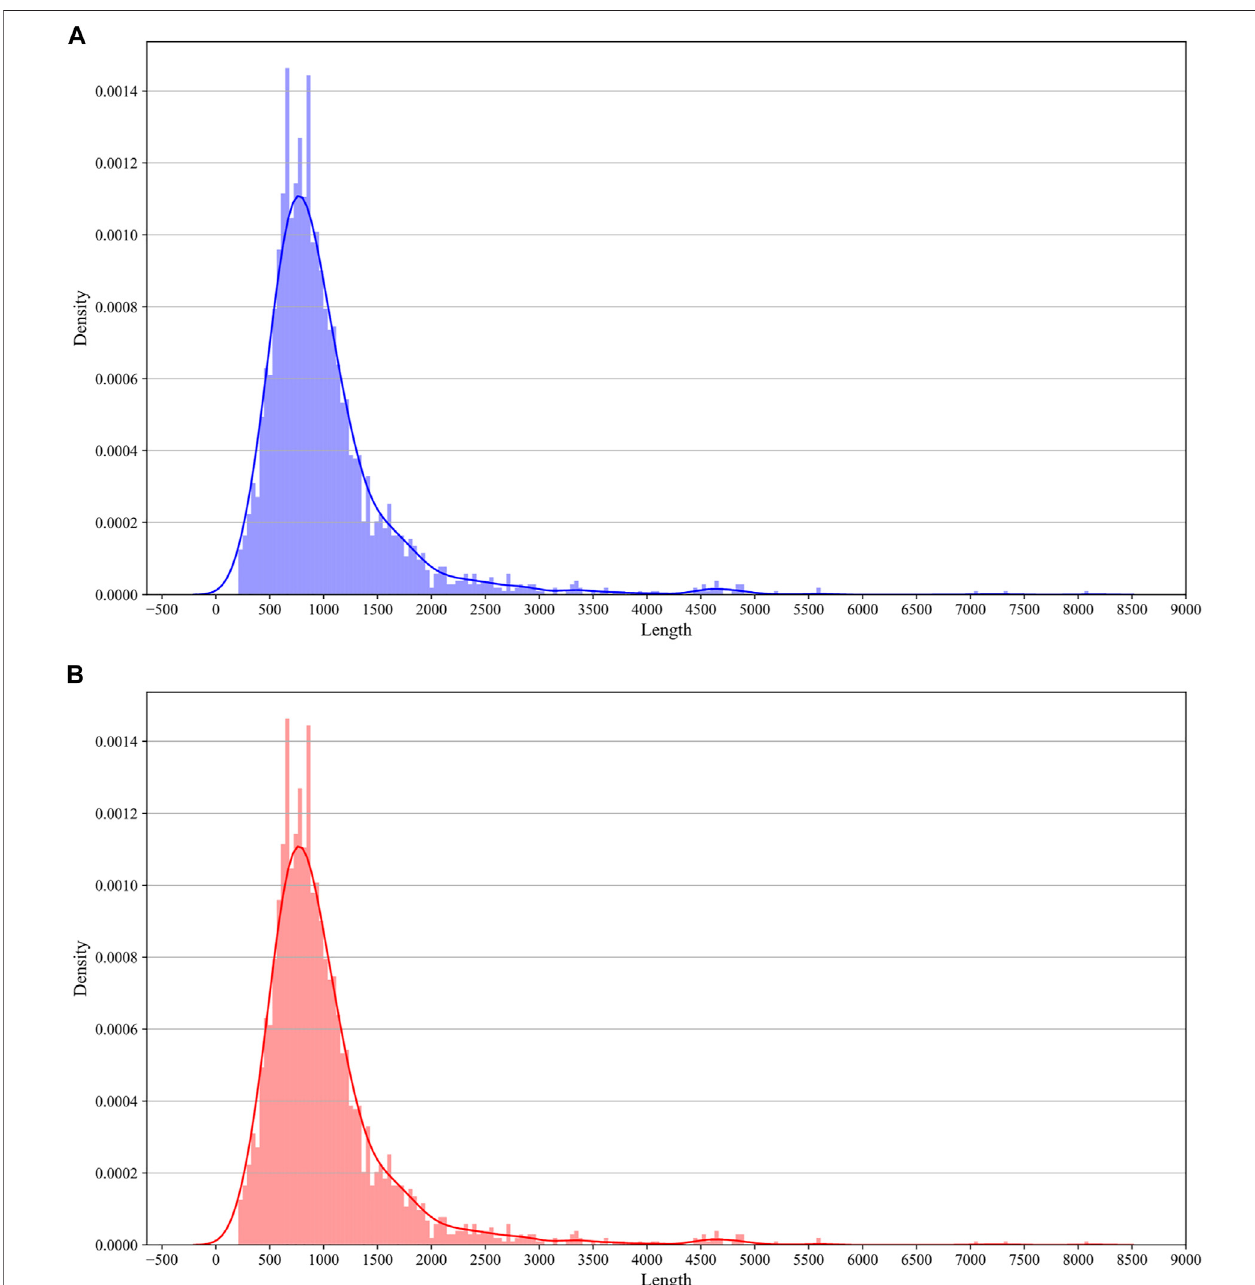
FIGURE 1 | Sequence length distribution. The X-axis represents the length of sequences. The Y-axis represents the density of distribution. (A) Histogram density for the distribution of the length of positive sequences. (B) Histogram density for the distribution of the length of positive sequences.